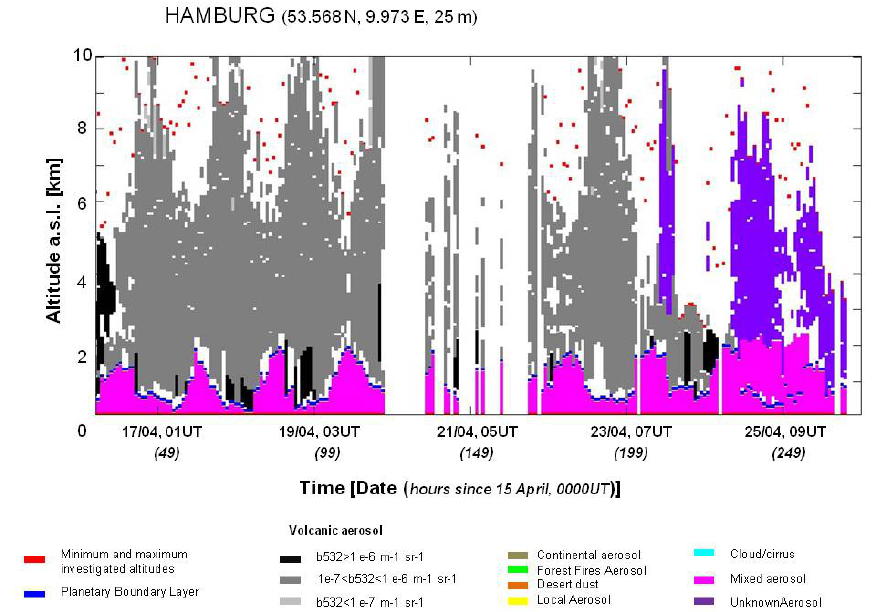
Fig. 1. Aerosol mask for the Hamburg EARLINET site in the 15–25 April 2010